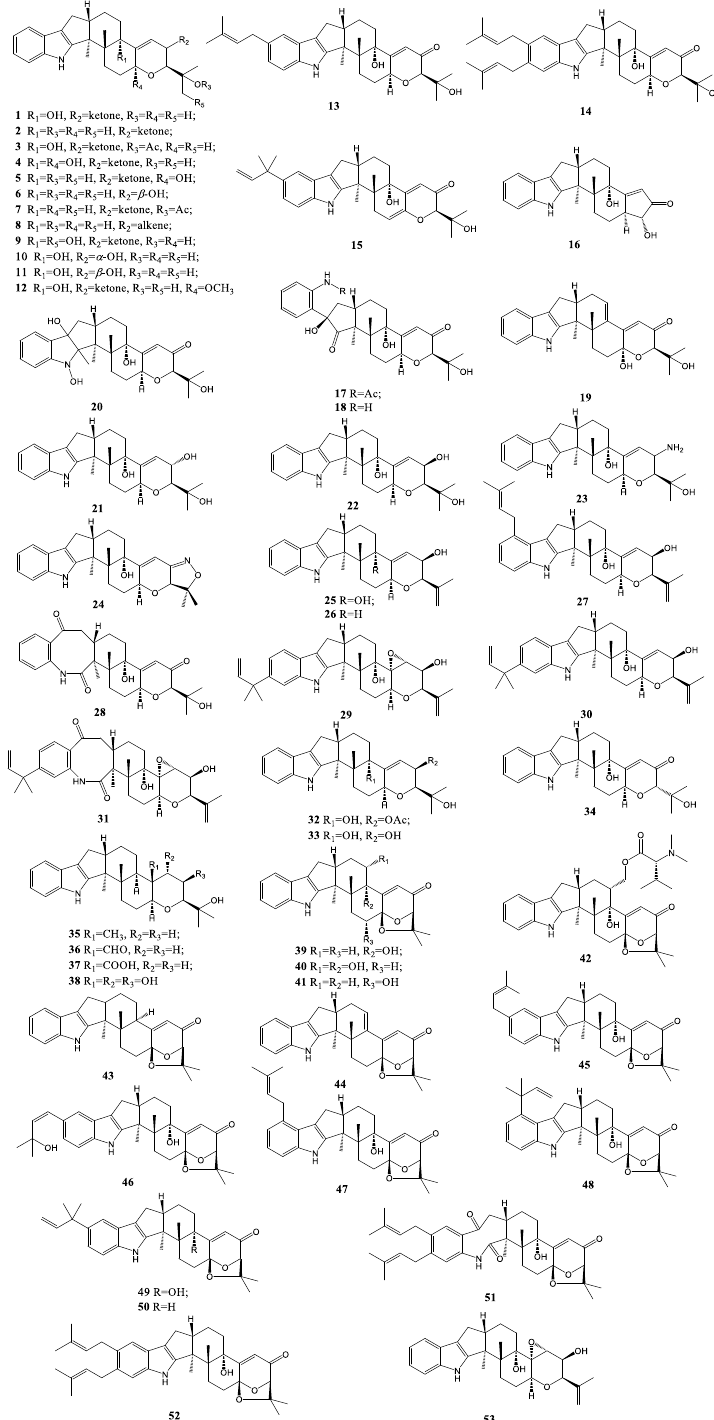
Figure 3. Paxilline-like indole diterpenoid compounds ( 1 – 53 ).